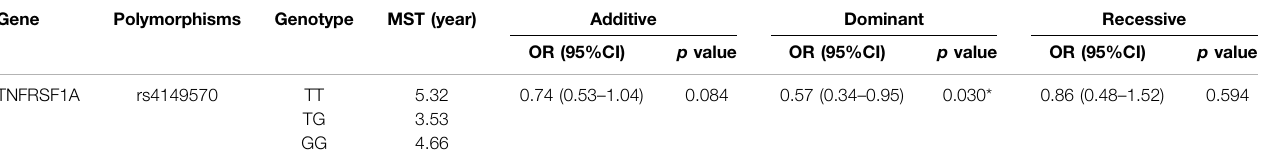
TABLE 4 | Association of the TNFRSF1A rs4149570 polymorphisms and OS in lung cancer patients. Gene